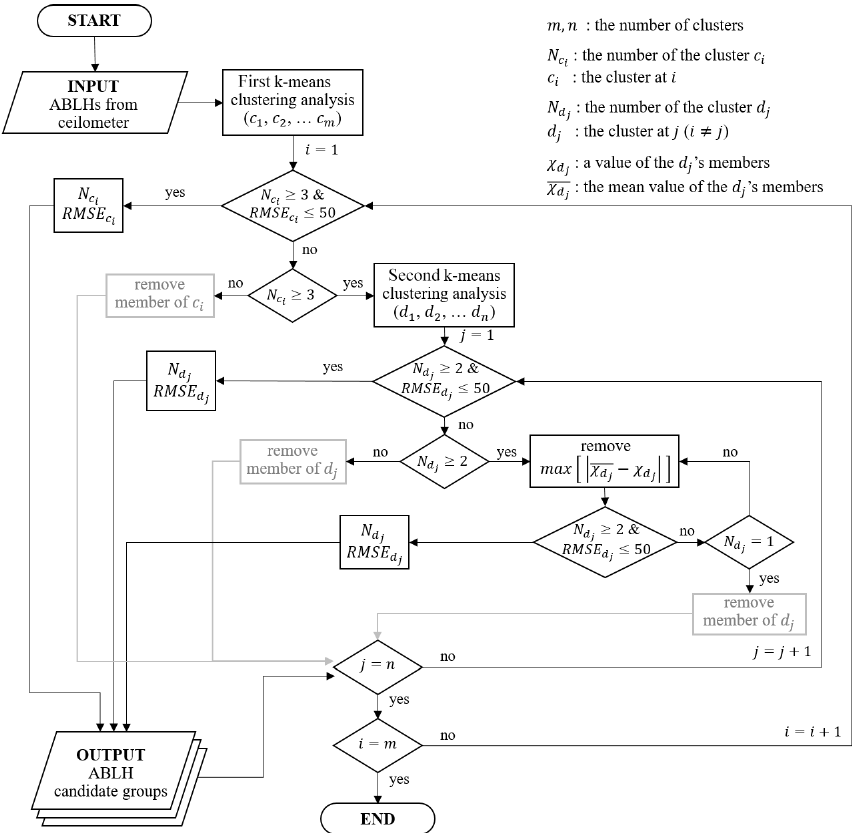
Figure 6. Flowchart of the algorithm for ABLH estimation from the vertical profile of the backscattering coefficient obtained using a